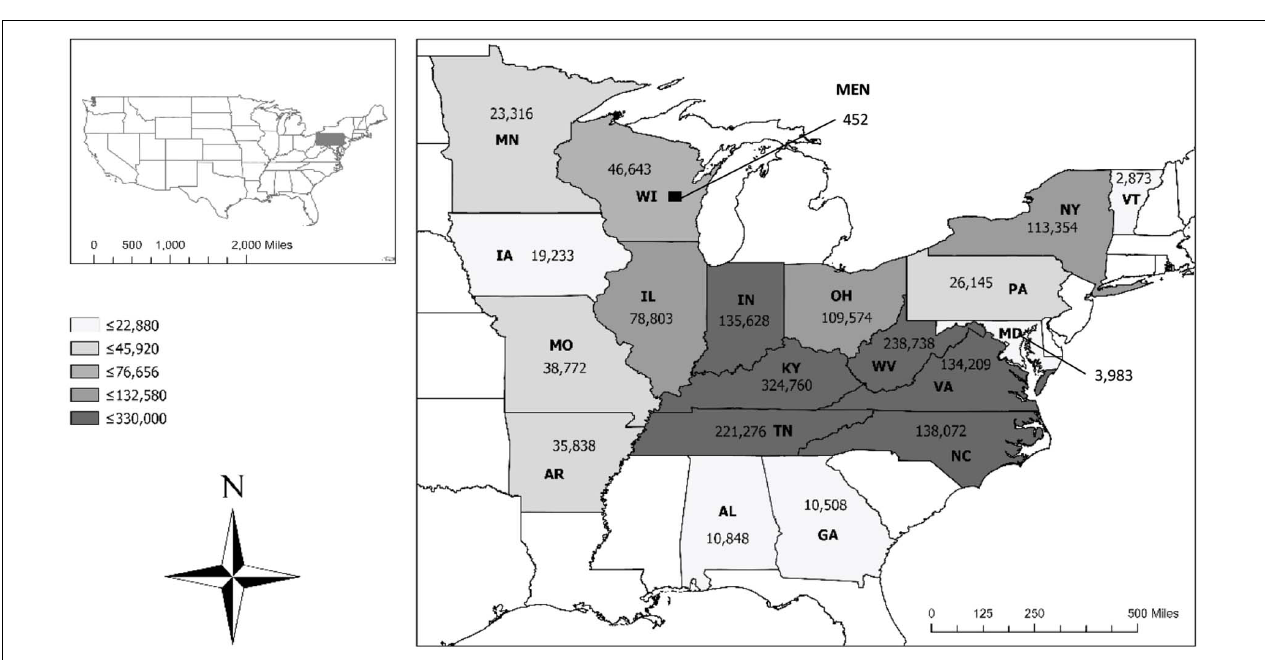
FIGURE 2 | Geographic origins of wild American ginseng harvest exports from the U.S.A. 1978–2019. Shading and labels indicate states with legal export programs. Darker shading indicates greater exports. The year in parenthesis below notes the first year of reported data if different than 1978. Data source: USFWS 2020. State abbreviations: AL = Alabama (1988), AR = Arkansas (1979), GA = Georgia, IL = Illinois, IN = Indiana, IA = Iowa, KY = Kentucky, MD = Maryland, MN = Minnesota, MO = Missouri, NY = New York, NC = North Carolina, OH = Ohio (1980), PA = Pennsylvania (1989), TN = Tennessee, VT = Vermont (1984), VA = Virginia (1980), WV = West Virginia, WI = Wisconsin (1981), MEN = Menominee Nation